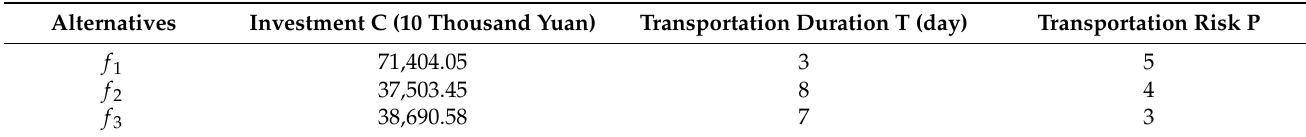
Table 4. The attribute values of the three decision